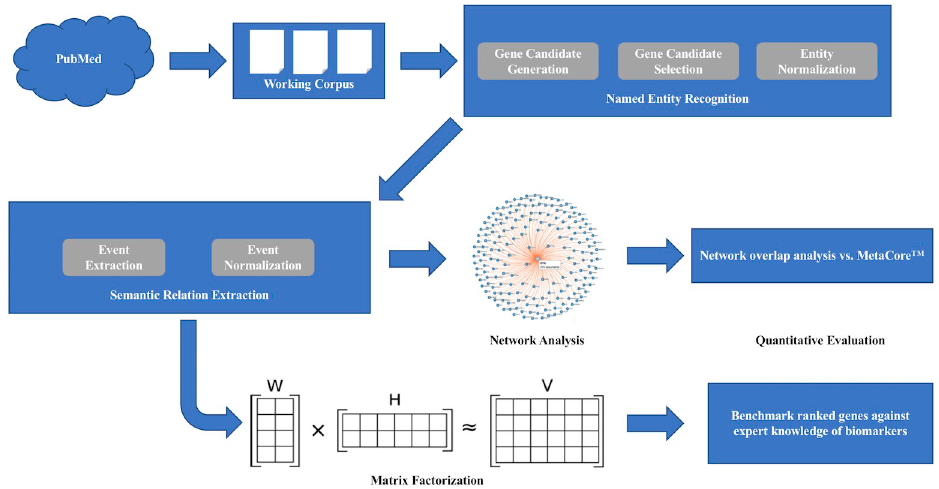
Fig 1. Overview of pipeline used for identification of putative BTK inhibition biomarkers. Pubmed abstracts were used as an input for generating a working corpus from which gene entities were identified, selected, and normalized for generation of a relationship network. This relationship network was used for comparison to the MetaCore curated database and further analysis using matrix factorization for the prediction of potential BTK biomarkers and compared to a list of potential BTK biomarkers created by subject matter